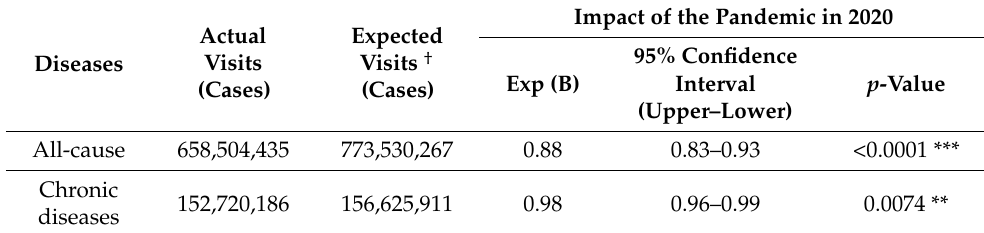
Table 1. Assessment of the Pandemic’s Impact on OP Visits in